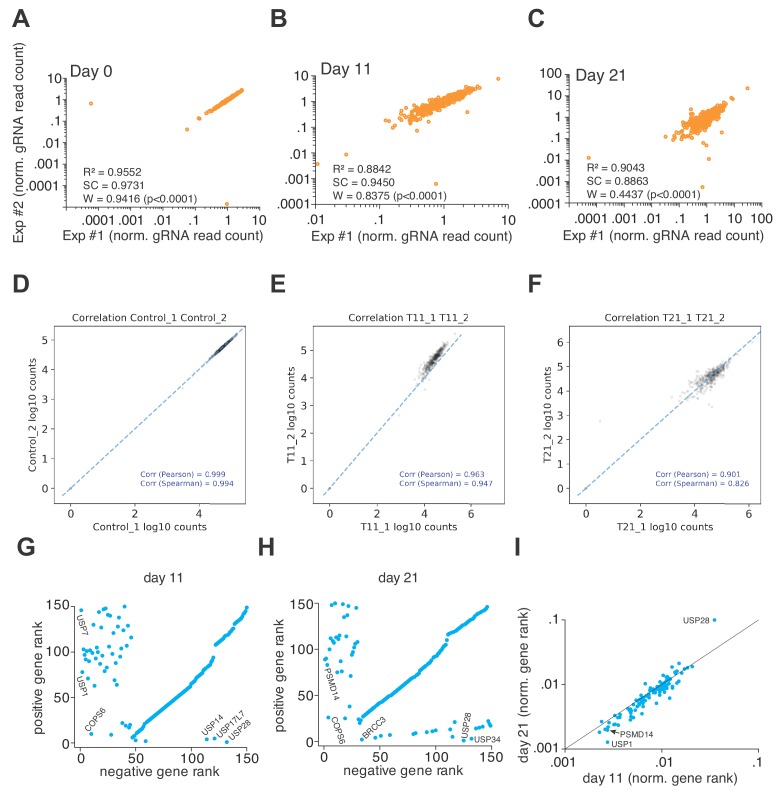
The 3Cs DUB gRNA screens are highly reproducible.(A–C) 3Cs DUB gRNA screens are highly reproducible, as visualized by scatter plots comparing biological replicates (Exp#1/Exp#2) of normalized gRNA read counts at each time point: day 0 (A), days 11 (B) and day 21 (C). High linear regression (R2 between 0.8842 and 0.9552), spearman correlation (SC between 0.8863 and 0.9731), and Shapiro–Wilk confidence (W between 0.4437 and 0.9416), including highly significant statistical testing (p<0.0001), demonstrate high biological reproducibility. (D–F) gRNA read count tables of 3Cs DUB gRNAs were used as input for PinAPL-Py to perform positive and negative computational analyses. Experimental reproducibility is visualized by individual scatter plot at each time point: day 0 (D), day 11 (E), and day 21 (F). Please note, PinAPL-Py computes Pearson and Spearman correlations, both of which values are above 0.8 for all time points and biological replicates, demonstrating high experimental reproducibility. (G–H) Scatter plot of MAGeCK-derived positive and negative gene ranks, corresponding to data in Figure 3E. Genes of interest are highlighted. (I) Scatter plot showing normalized gene ranks at day 11 versus day 21. Data corresponding to Figure 3E.